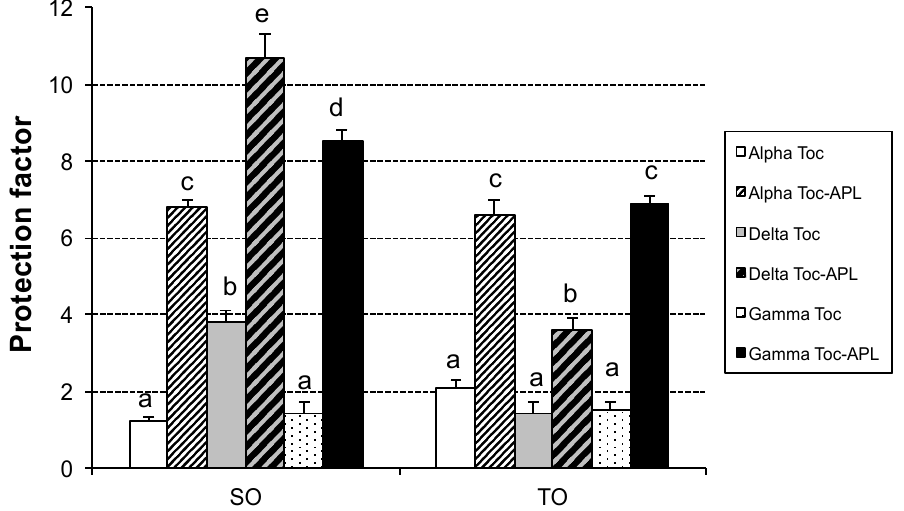
Figure 4. Protection factors (ratio between the oil stability index in the presence and absence of antioxidants) provided by tocopherol homologues alone and in combination with APL in safflower oil (SO) and Tonalin oil (TO) stripped of their naturally occurring antioxidants in Rancimat at 100 °C. Data are expressed as Means ± Standard Deviations ( n = 3). In each oil, different letters mean significant differences ( p < 0.05). Toc: Tocopherol; APL: Ascorbyl Palmitate and